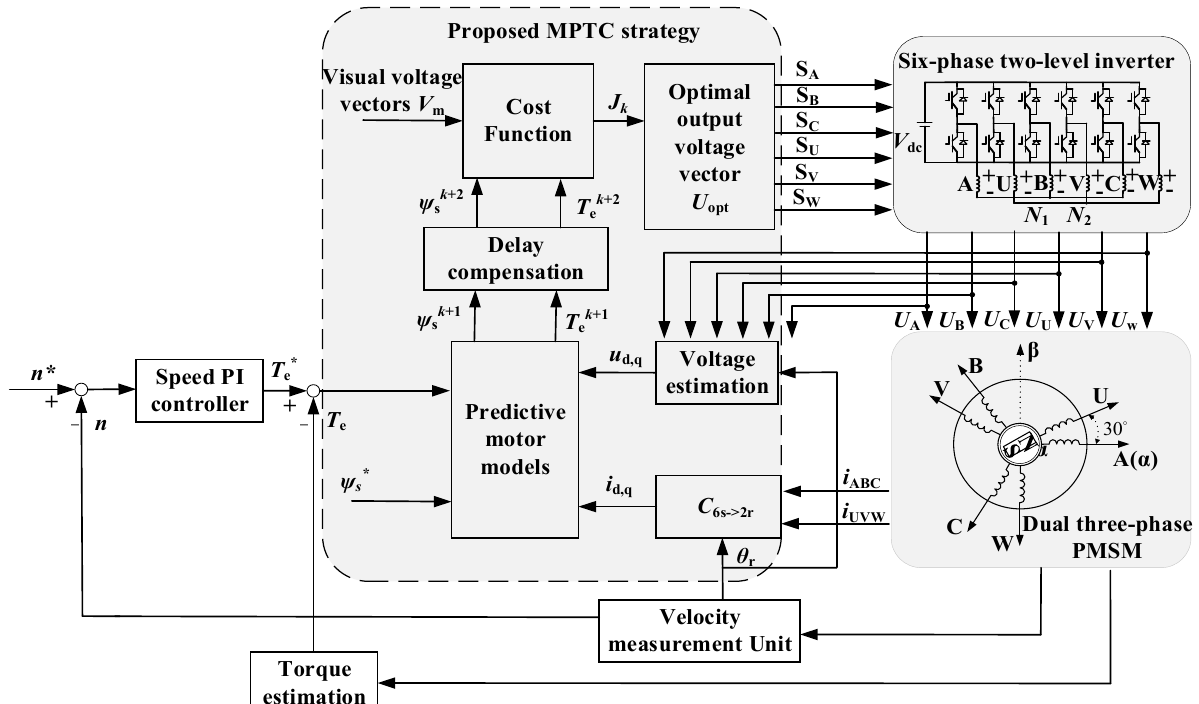
Figure 7. Control diagram of the proposed MPTC strategy.